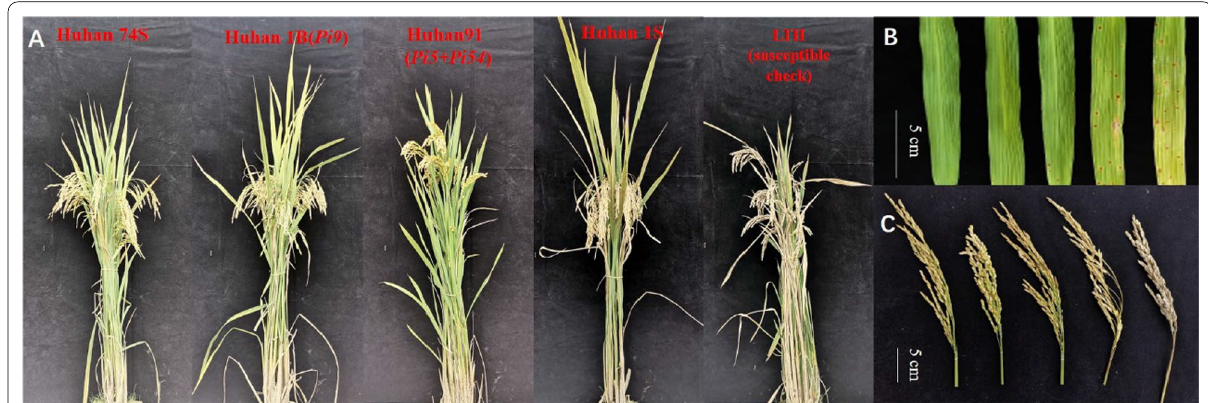
Fig. 3 The performance for blast resistance of Huhan 74S, parents, and susceptible check in blast epidemic field. A The whole plant; B the leaf blast reactions; C the neck blast reactions; from the left to the right are Huhan 74S, Huhan 1B( Pi9 ), Huhan 91( Pi5 check); Scale bars: 5 cm